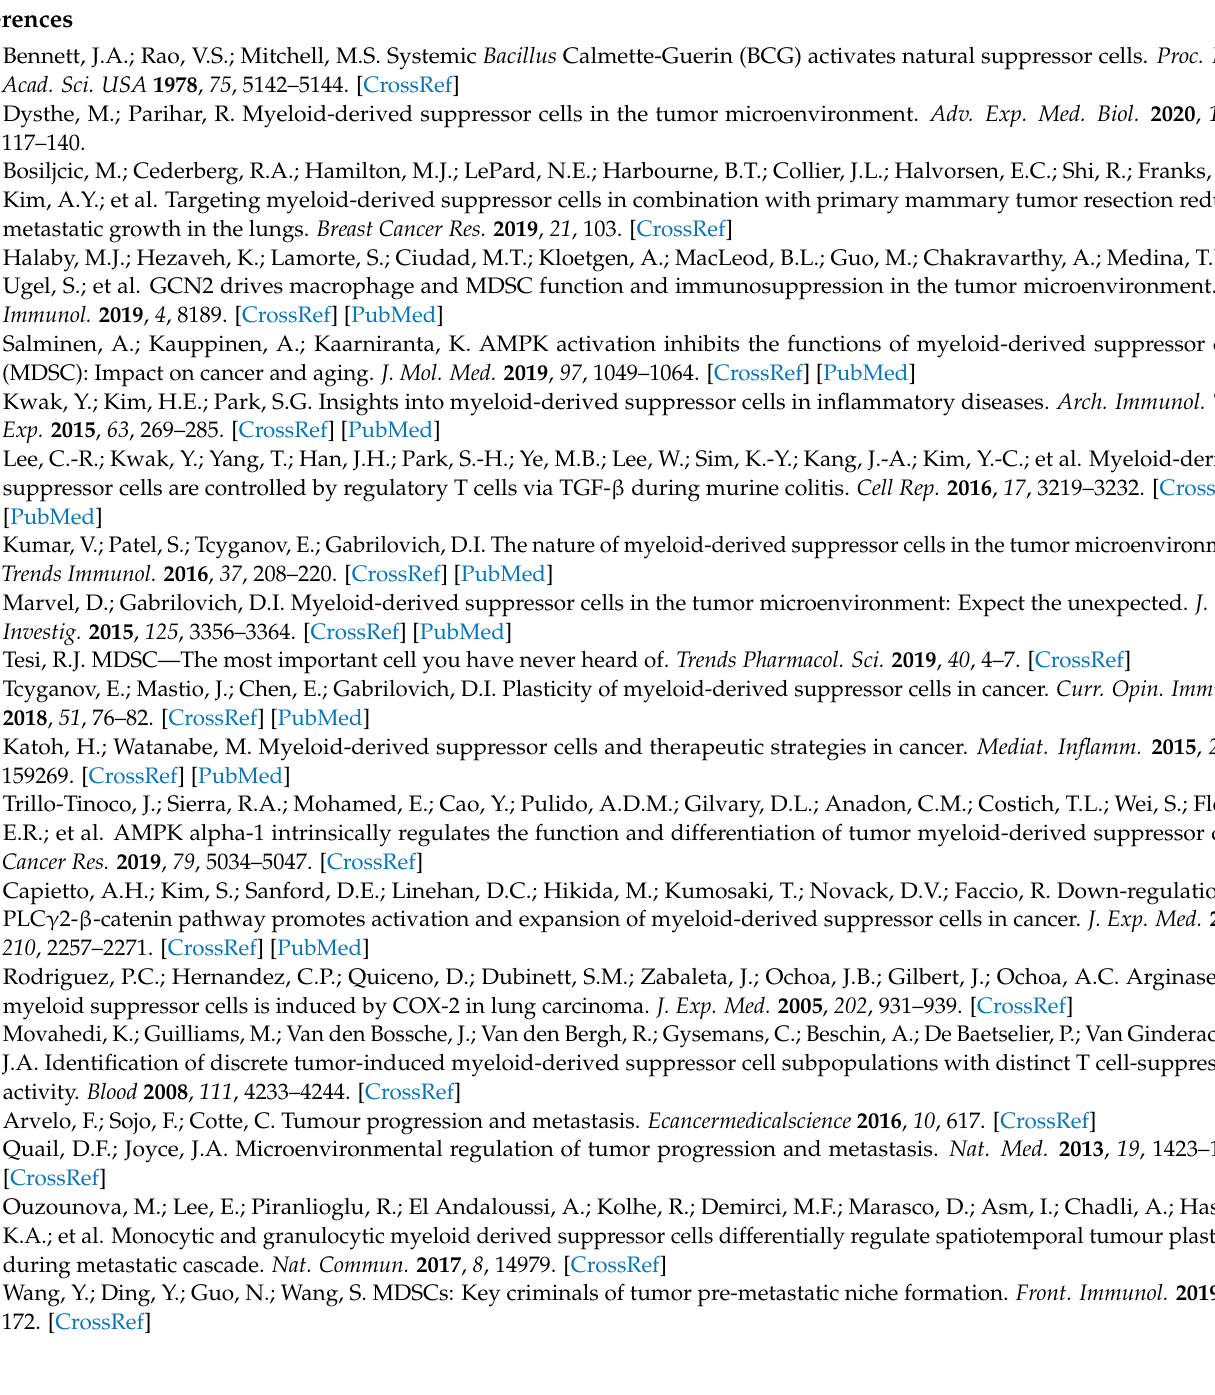
Figure A2. S-Mfge8 expression level is higher than L-Mfge8 in B16F10 cells. Analysis of L-MFGE8 and S-MFGE8 mRNA levels in B16F10 cells by qPCR. Data are expressed as the mean ± SD. * p < 0.05 by two-tailed t -test.